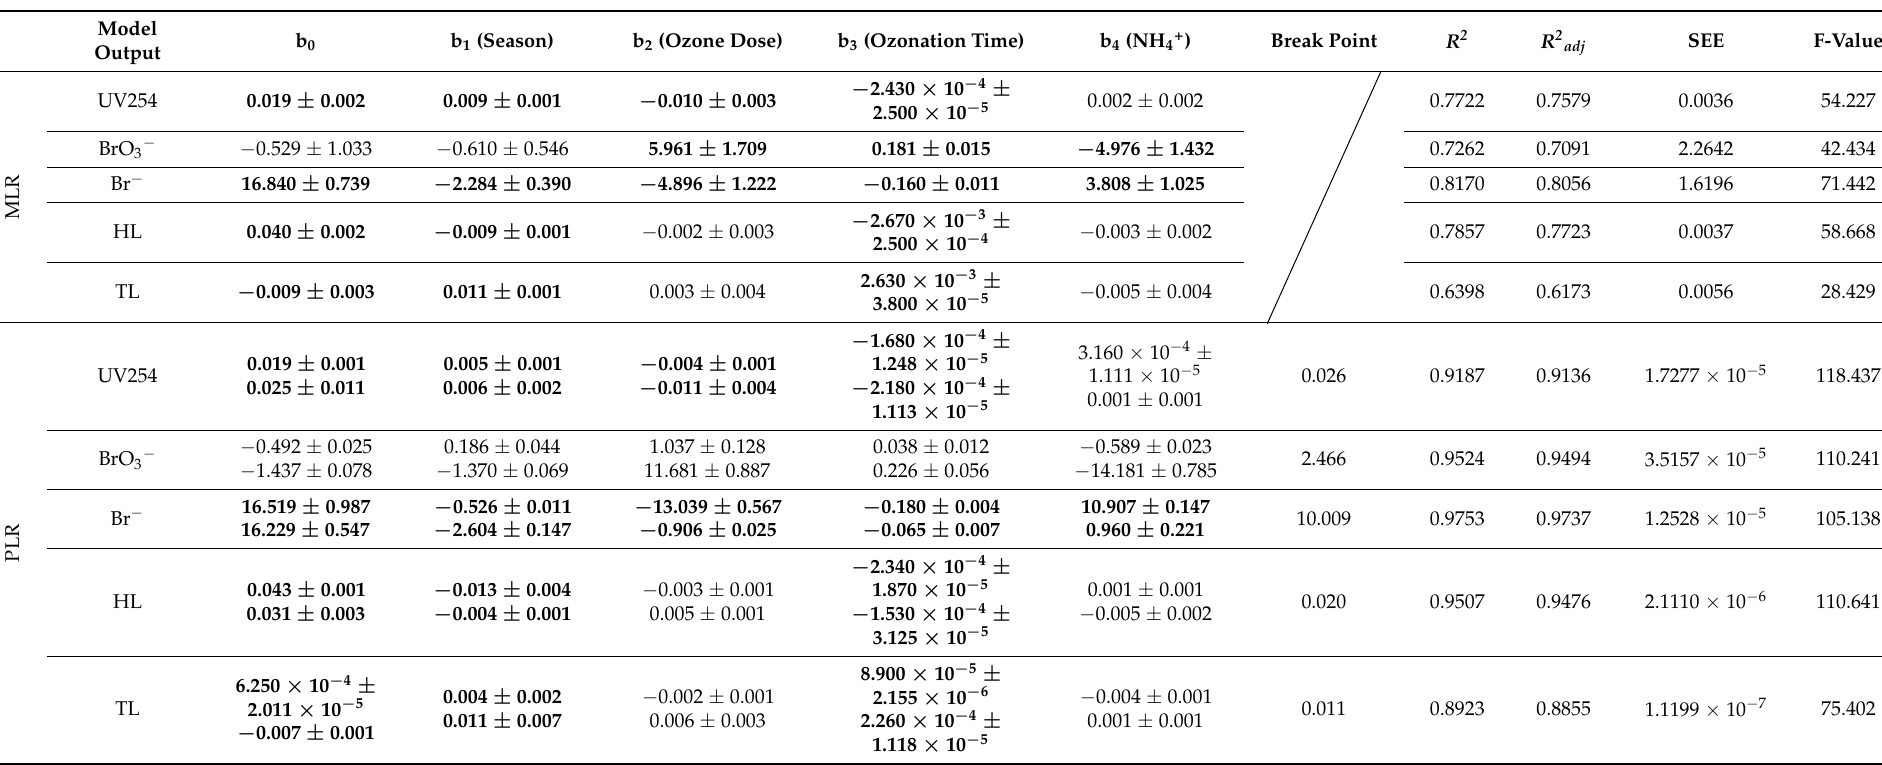
Table 3. MLR and PLR model coefficients. Values marked bold are significant at p < 0.001. ( R 2 adj = R 2 adjusted; SEE = standard error; F-value critical for this dataset was